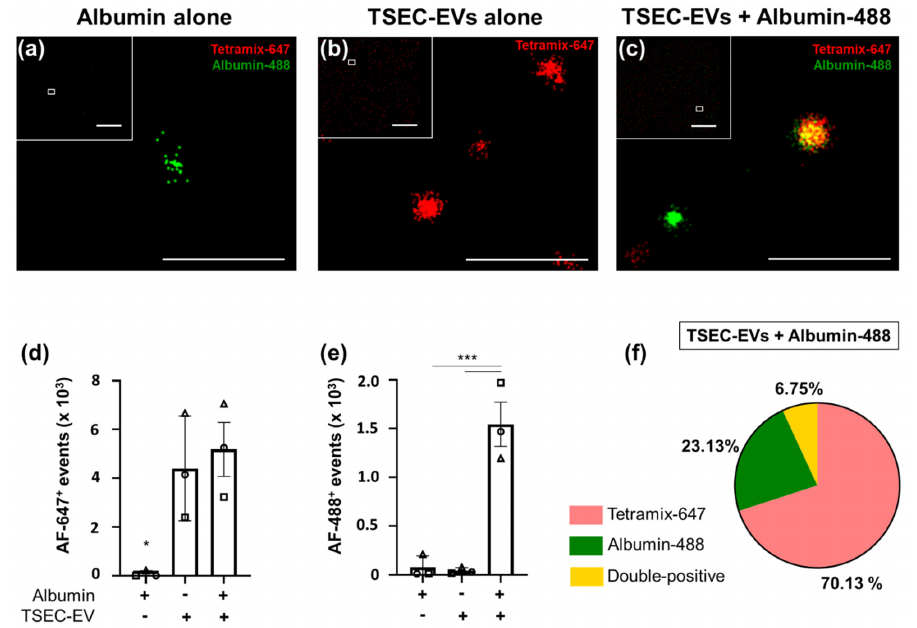
Figure 6. Artificial reconstitution of a protein corona on HPL EVs. TSEC-EVs (5.4 × 10 8 ) were labeled with anti-CD9, CD63 and CD81 tetramix-AF-647 with or without prior albumin-AF-488 corona for- mation and loaded onto EV profiler chips (ONI). High resolution pictures with overview inserts are shown. ( a ) Negative control albumin-AF-488 solution in the absence of EVs did not bind to the chip; one single positive presumably albumin aggregate is shown in magnification. ( b ) Control tetramix- AF-647-labeled TSEC-EVs without albumin label bound to the chip showing red signal, with negli- gible signal in the green channel. ( c ) Albumin-AF-488 pre-labeled and tetramix-AF-647 stained TSEC-EV samples produced easily detectable double-positive signals. ( d ) Quantification of AF-647 signals and ( e ) quantification of AF-488 signals on chips loaded as indicated with albumin solution or TSEC-EVs without or with previous fluorescent albumin corona formation. ( f ) In chips loaded with albumin-AF-488-prelabeled TSEC-EVs, represented in ( c ), 6.75 ± 2.18% double-positive, 70.13 ± 11.62% tetramix-647 positive and 23.13 ± 10.70% AF-488 positive events were detected. One-way ANOVA, Tukey, *** p ≤ 0.001, * p ≤ 0.05. Each symbol (circles, squares and triangles) represents a separate independent experiment ( n = 3). Scale bars: 10 µm (low resolution inserts) and 0.5 µm (main